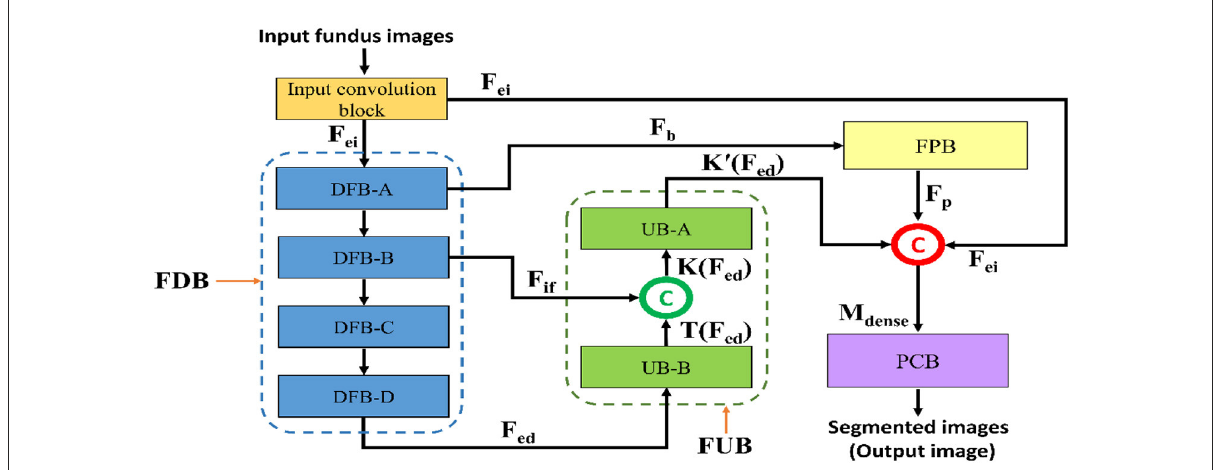
FIGURE3 The schematic diagram for FPM-Net connectivity, FDB, FUB, FPB, and PCB represents the feature down-sampling block, feature up-sampling block, feature preserving block, and pixel classification block, respectively.